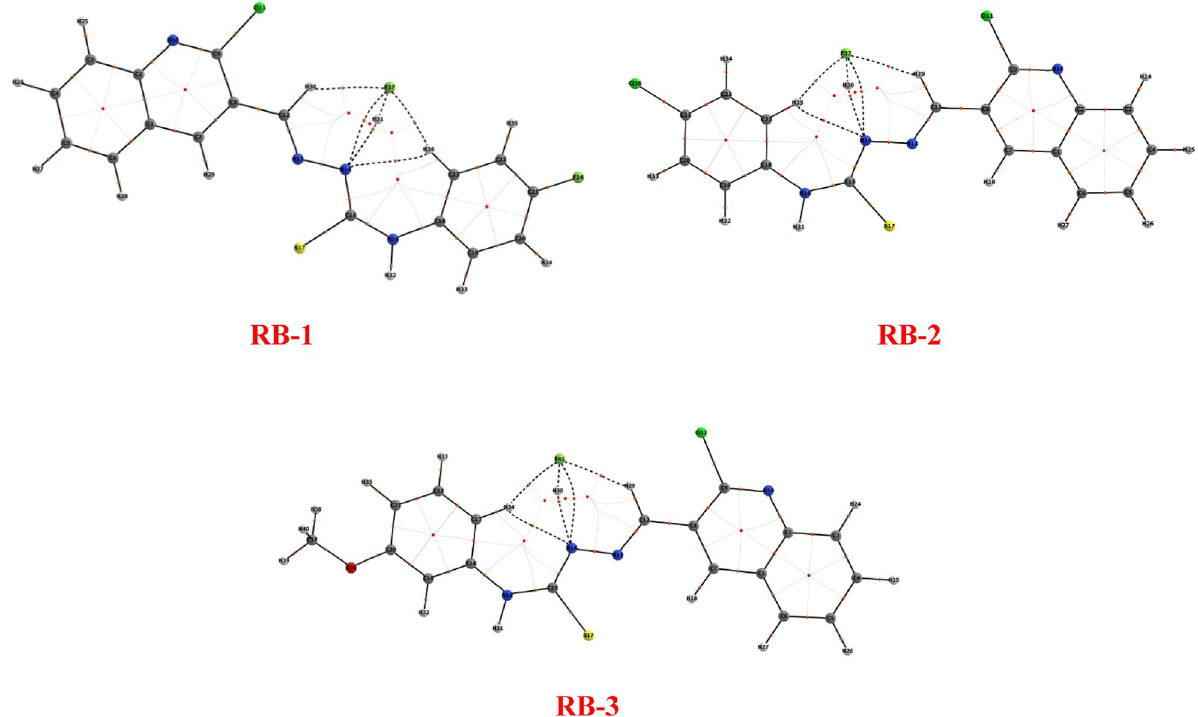
Figure 10. Schematic structure of AIM analyses for RB-1, RB-2 and RB-3 compounds